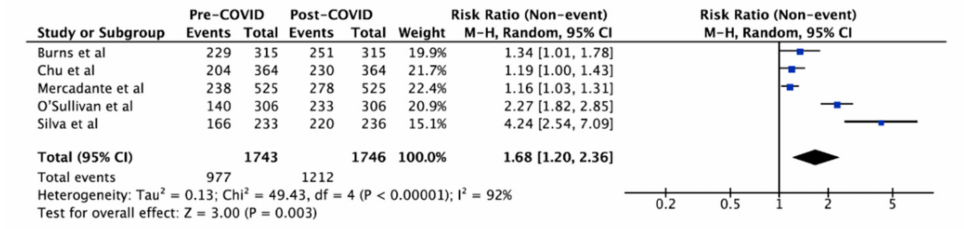
Figure 5. Influenza vaccination uptake pre-COVID-19 vs update and intention post-COVID-19. The squares and rhombus represent the individual and pooled point effect estimates with 95% confidence intervals